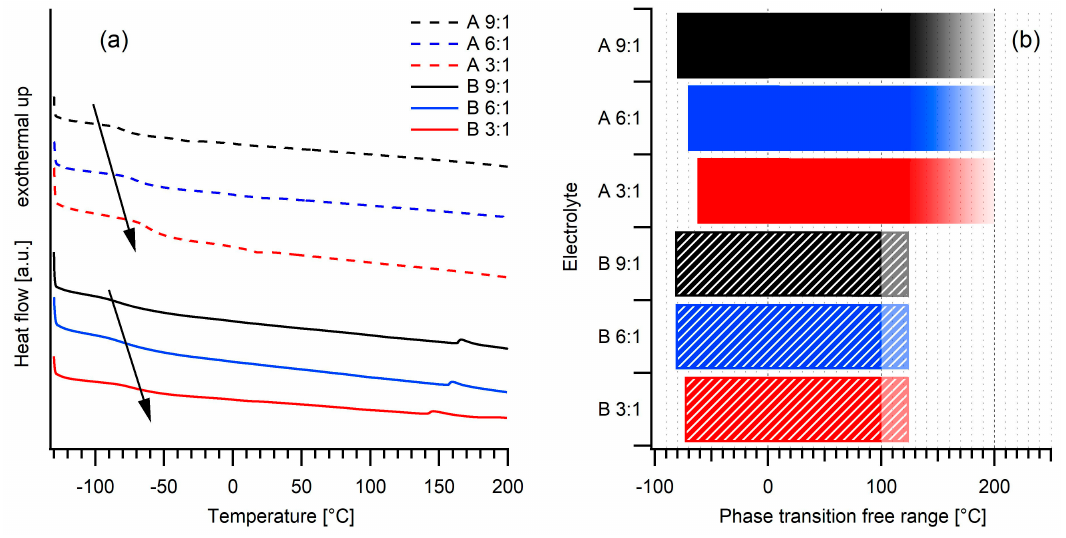
Figure 2. DSC heating traces ( a ) and phase transition free ranges ( b ).